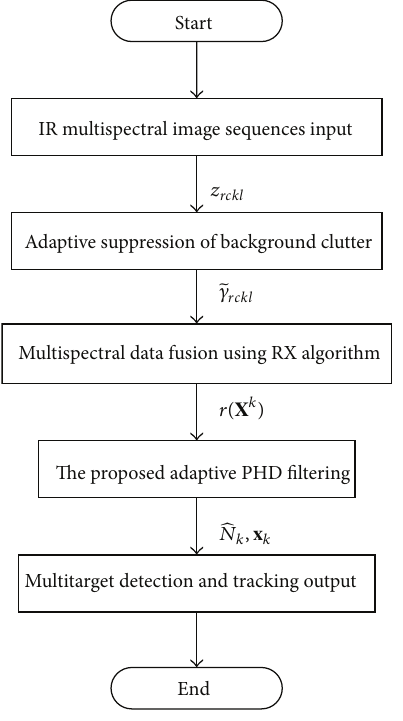
Figure 2: The processing chain of the proposed approach.